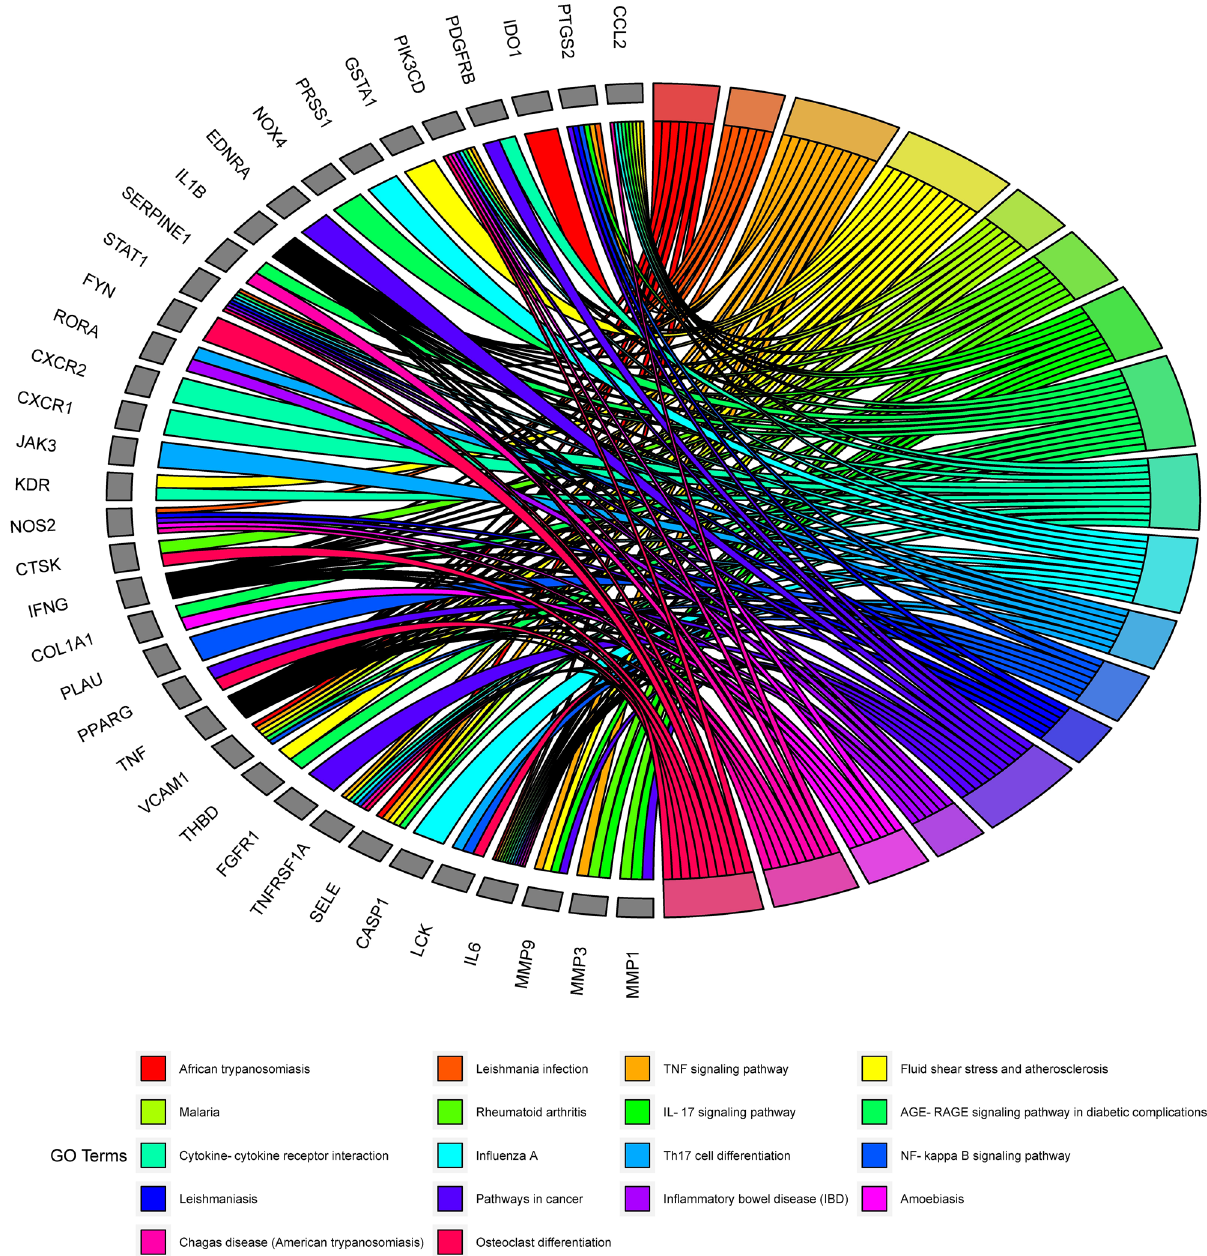
Figure 7. The top 20 pathways for KEGG enrichment analysis for overlapping 79